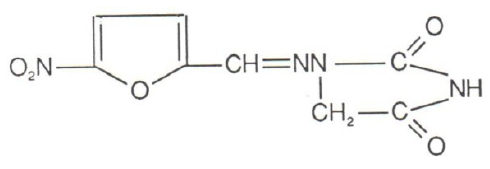
Figure 1. Chemical structure of